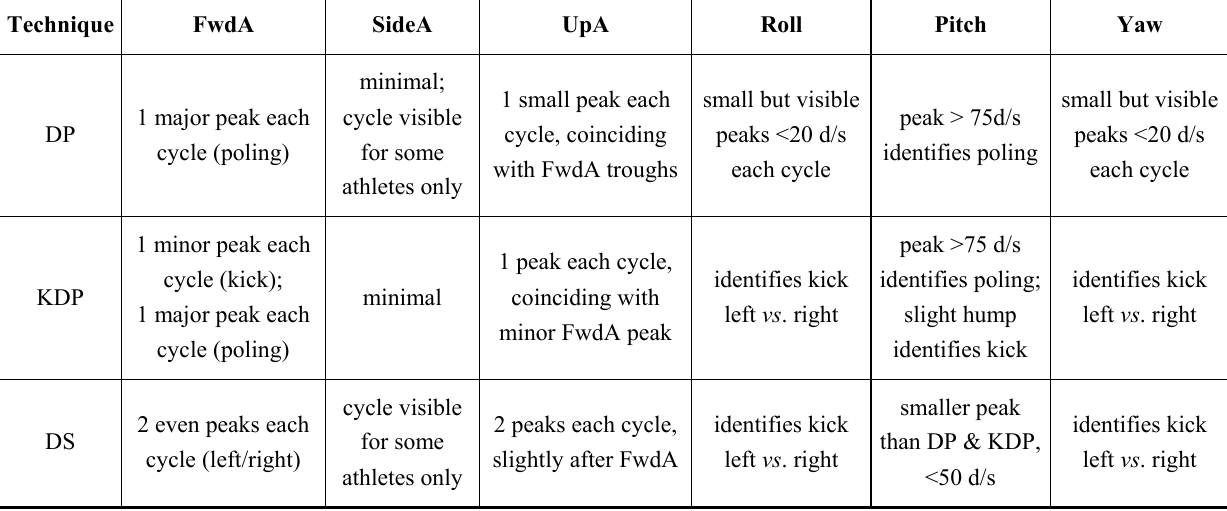
Table 1. Classical technique features common to all athletes.